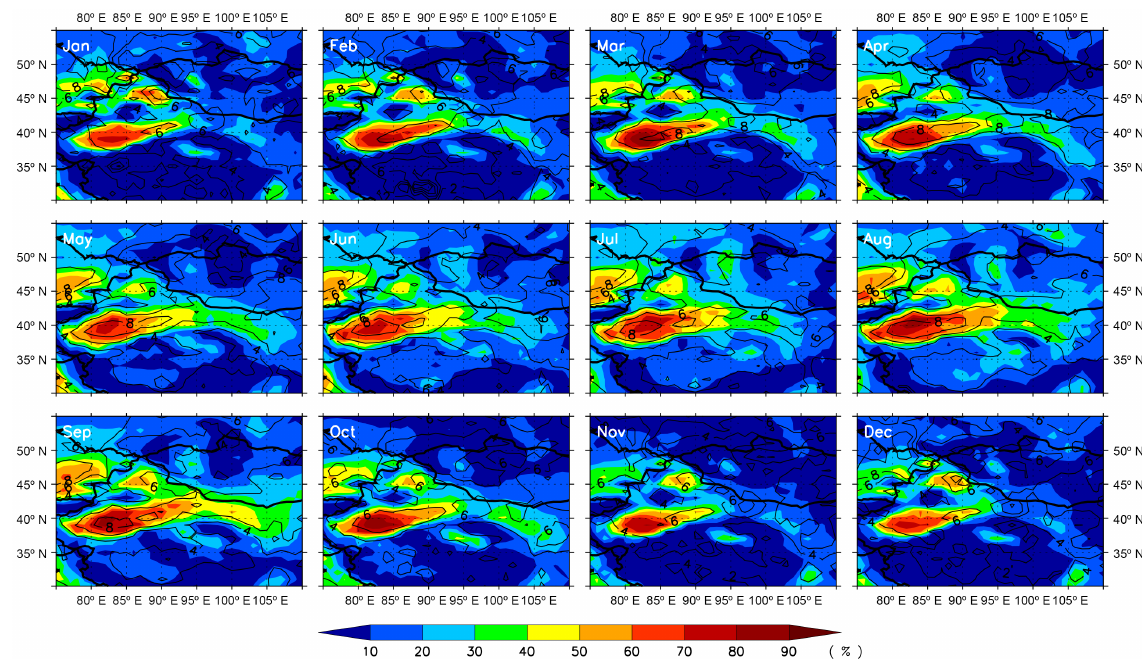
Figure 5. Monthly mean occurrence of NLLJs (colors) with jet core wind speed (contours) at 00:00UTC by applying the NLLJ detection algorithm to the ERA-Interim reanalysis data for